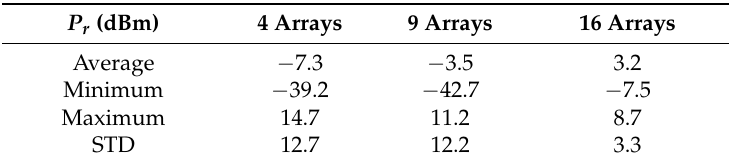
Table 4. Power received at ∅ (cid:2869)/(cid:2870) = 10°.